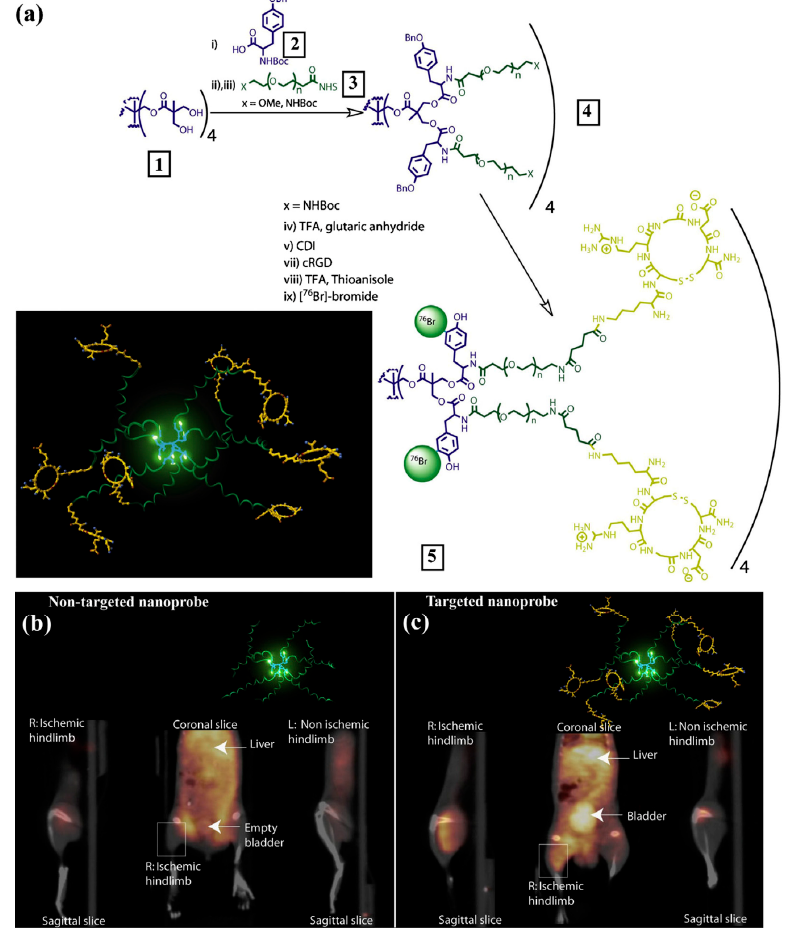
Figure 5. ( a ) Preparation of PET nanoprobes targeted at α v β 3 integrin; ( b ) Noninvasive PET/CT images of angiogenesis induced by hindlimb ischemia in amurine model for nontargeted dendritic nanoprobes (shown bottom center); ( c ) Noninvasive PET/CT images of angiogenesis induced by hindlimb ischemiain a murine model for α v β 3 -targeted dendritic nanoprobes, which showed higher uptake in ischemic hindlimb (left side of image) as compared with control hindlimb (right side of image) (adapted from [31], Progress in Polymer Science, 2015).